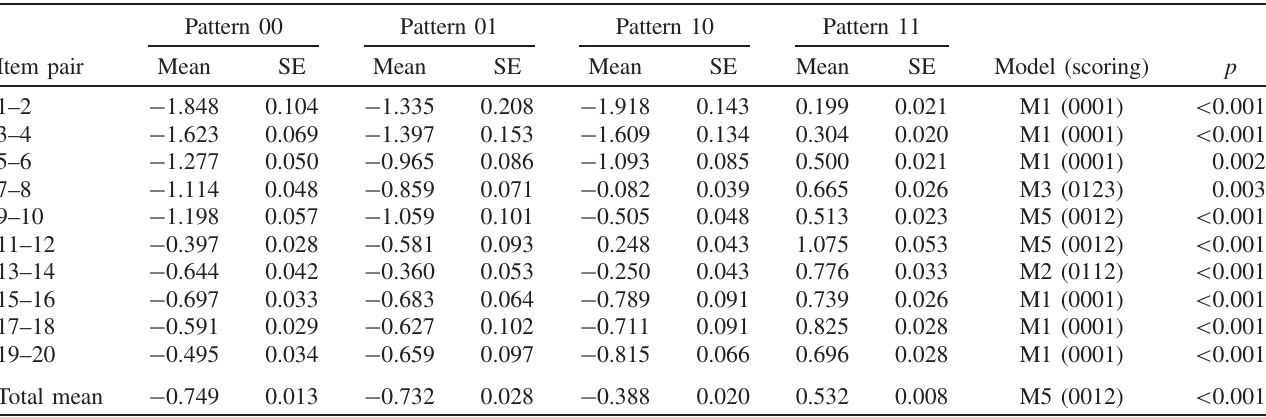
TABLE V. Item-level students ’ abilities of response patterns of